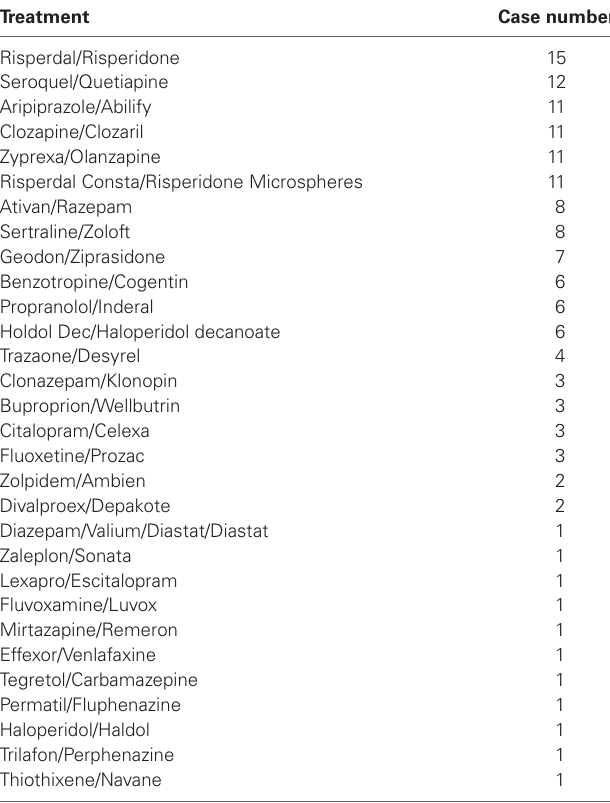
Table 2 | Treatment details of schizophrenia patients .